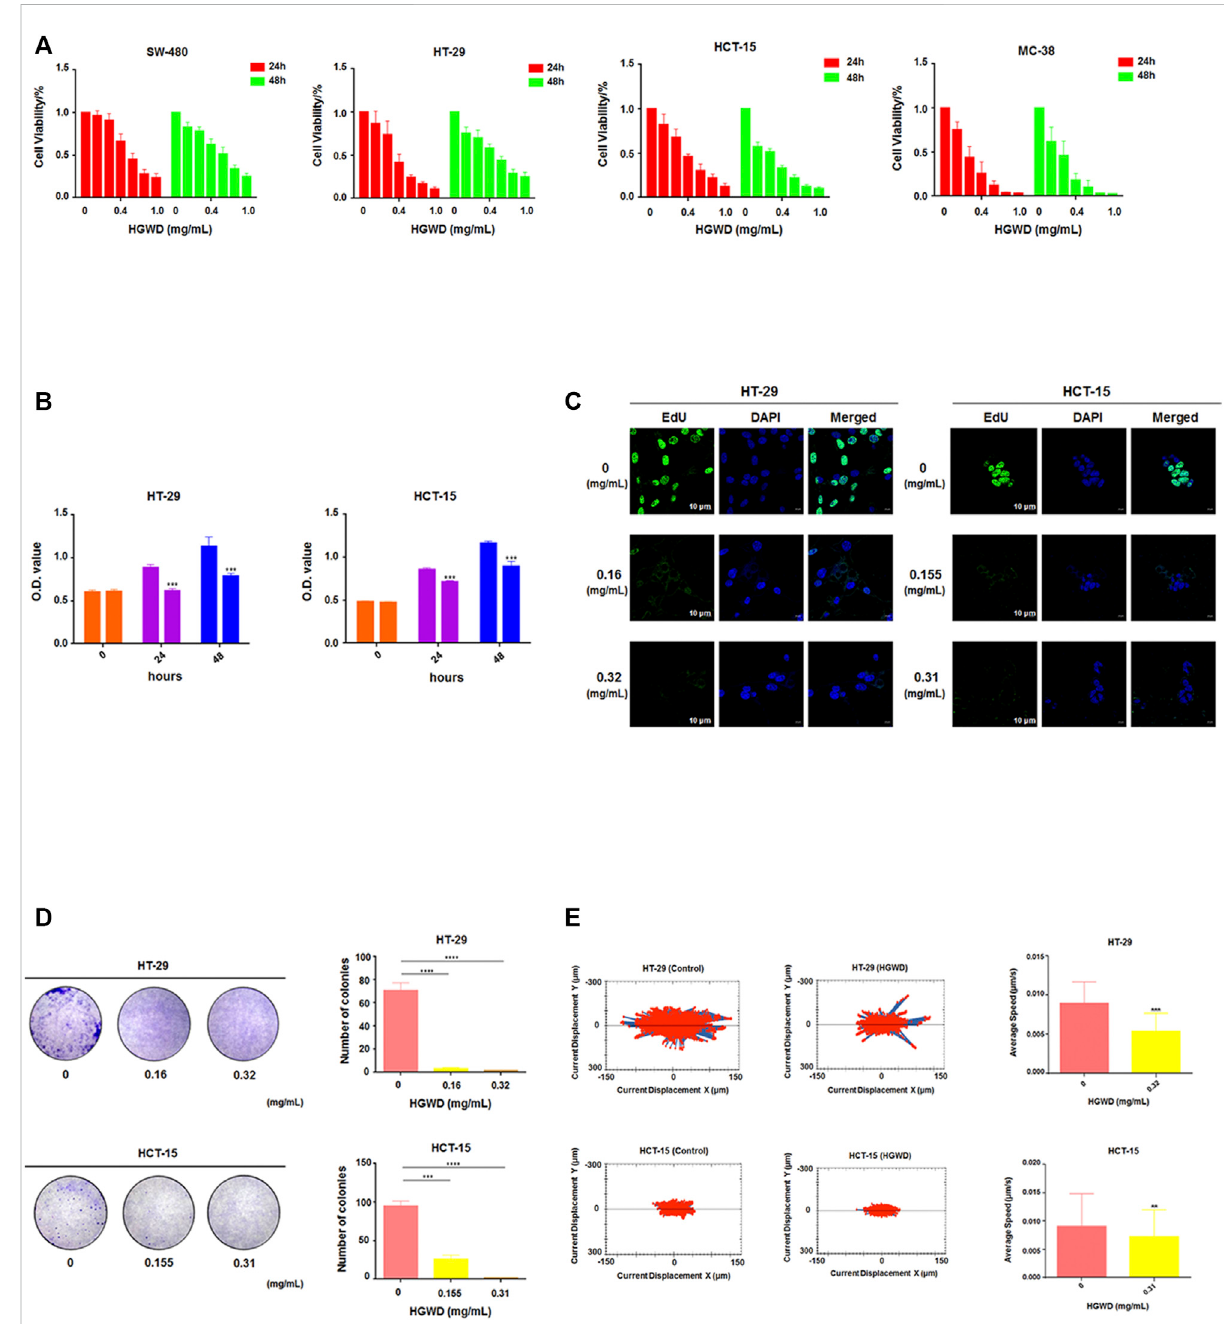
FIGURE 3 HGWD suppressed CC cell proliferation and their viability. (A) CCK-8 assay was done to assess CC cells viability at 24 and 48 h after HGWD treatment at various doses (0, 0.1, 0.2, 0.4, 0.6, 0.8, 1.0 mg/ml). (B) CCK-8 assay was done to evaluate CC cells growth ability at 24 and 48 h after HGWD treatment at 24 h IC 50 (0.32 mg/ml and 0.31 mg/ml) in HT-29 and HCT-15 cells, respectively. *** p < 0.001. (C) EdU assay was conducted to assess CC cells proliferation ability after HGWD treatment for 24 h. (D) Cell colony formation assays were done to evaluate CC cells clonality after 24 h of HGWD treatment. *** p < 0.001 and **** p < 0.0001. (E) The Operetta CLS High Content Analysis System was used to assess the accumulated distance of CC cells at 24 h after HGWD treatment. ** p < 0.01 and *** p <